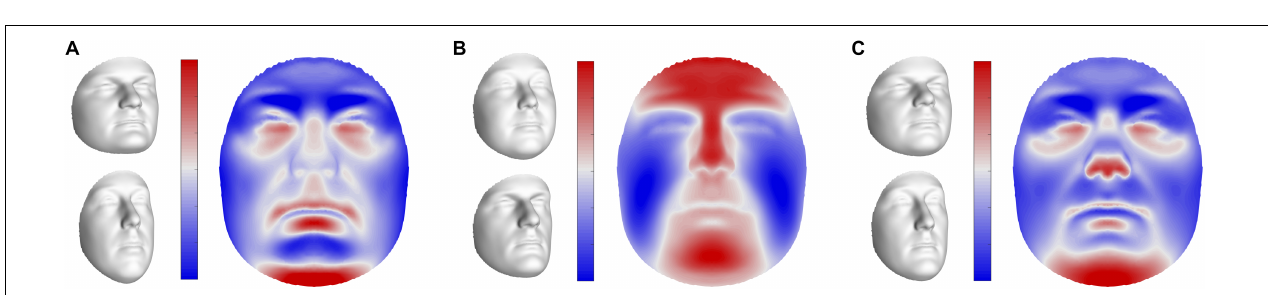
FIGURE 4 | Heritability of different global-to-local parts in the face. Modular heritability estimates (%) for sons and daughters, as obtained from the regression on fathers. Each node corresponds to the facial segments depicted in Figure 3 . The red-blue spectrum represents levels of high and low heritability, respectively, and the corresponding values are plotted on top of each node. Black-encircled facial segments had p -values below the significance threshold correcting for the multiple-testing burden ( α = 1.3889 × 10 - 3 ). All significance tests were based on 1,000,000 permutations.